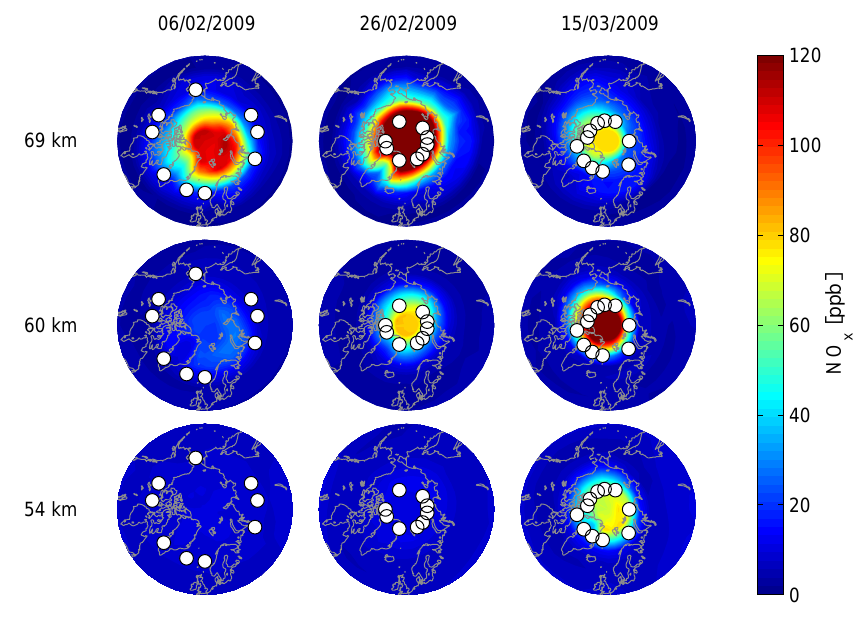
Fig. 7. Distribution of NO x inppb at 69, 60 and 51km altitudes (rows) on 6 and 26 February and 15 March (columns) in the northern polar region (50 ◦ N–90 ◦ N) calculated from the model results. White circles indicate the measurement locations of ACE-FTS on that particular